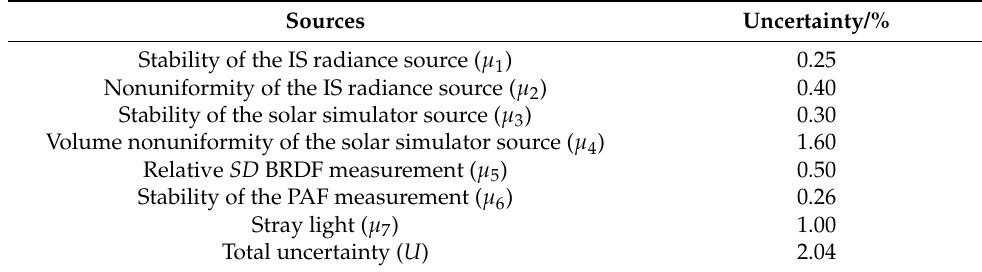
Table 3. Uncertainty analysis of the PAF